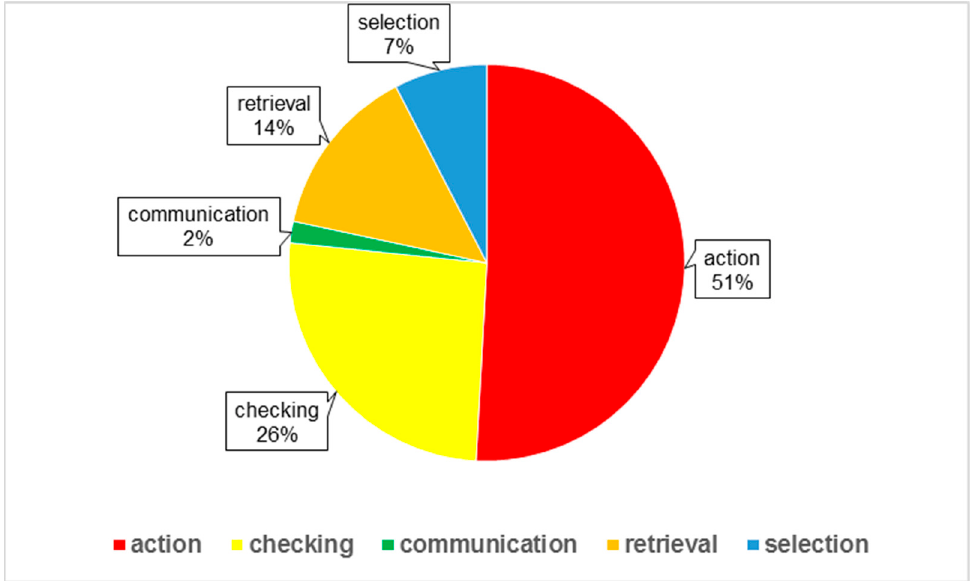
Figure 4. Percentage of the error types that emerged from the analysis.